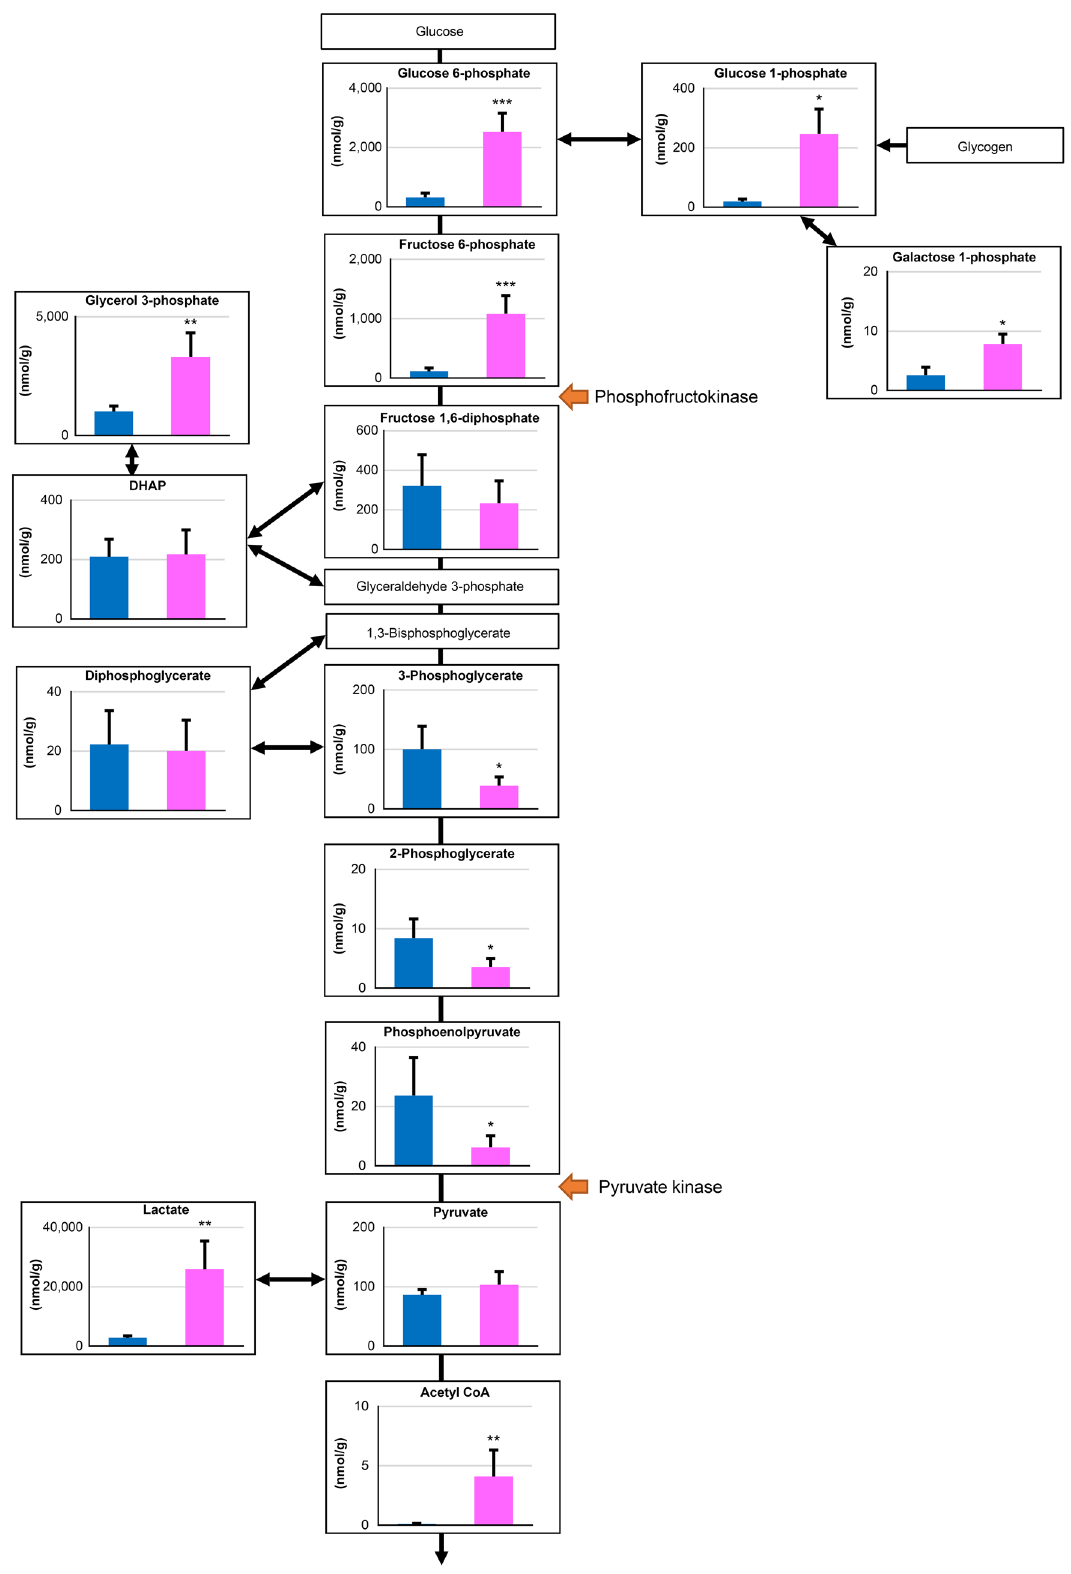
Figure 2. Observed changes in metabolites mapped onto the pathways associated with glycolysis. Asterisks show significant differences between before and after exercise by Welch’s t-test (* < 0.05, ** < 0.01, *** <